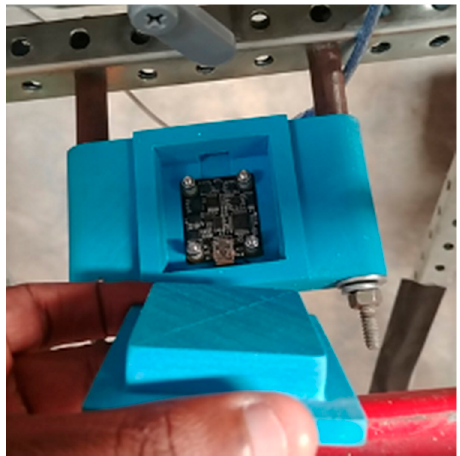
Figure 4. The first IMU Phidget Spatial Precision 3 / 3 / 3 High-Resolution model 1044_1B attached by using a 3D printed box to attach it to the rover.